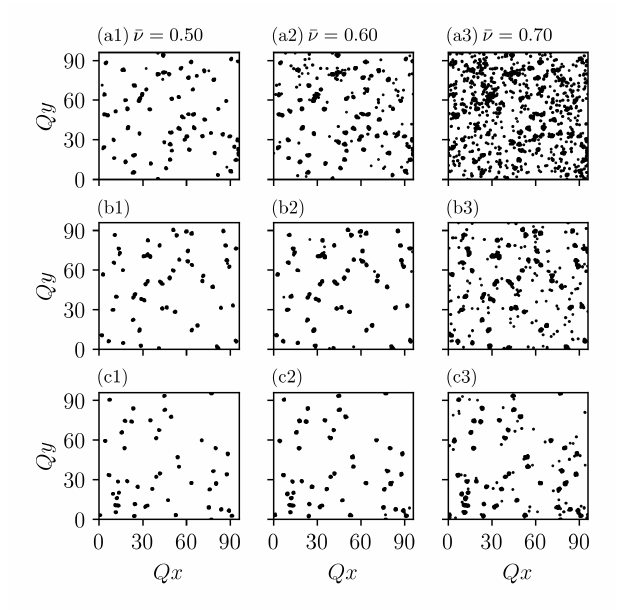
Figure 11: Example point clouds X ν ( t ) for different ¯ ν -values as indicated. Row (a): time Qt = 3750. Row (b): Qt = 7500. Row (c): Qt = 11250.